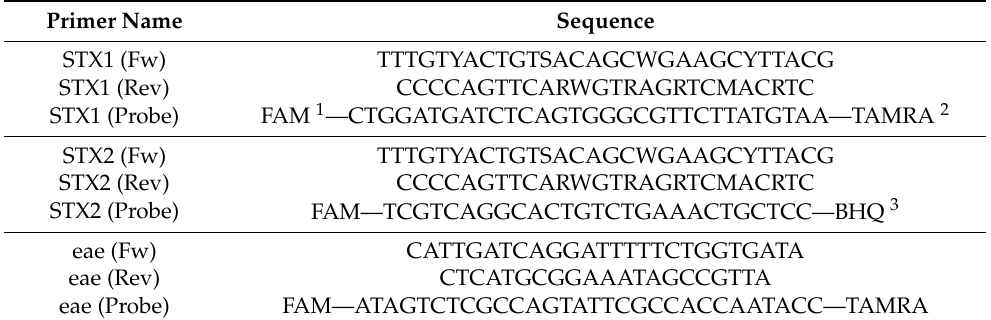
Table 2. Sequences of primers and probes used in Real-Time PCR and digital droplet